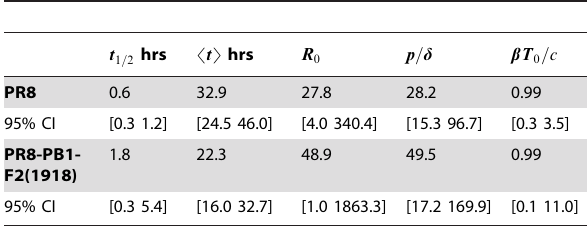
Table 3. Infection characteristics for influenza infection with PR8 and